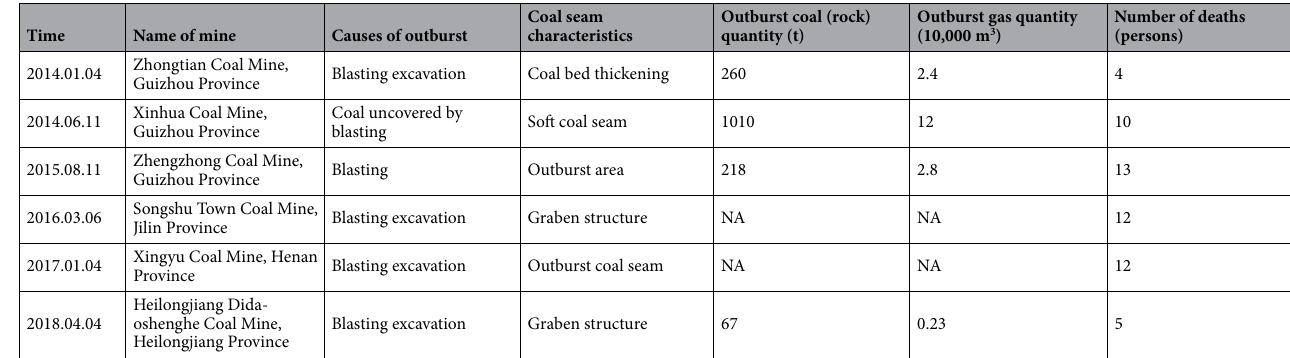
Table 1. Selected coal and gas dynamic disasters caused by blasting: summarised statistics in China.